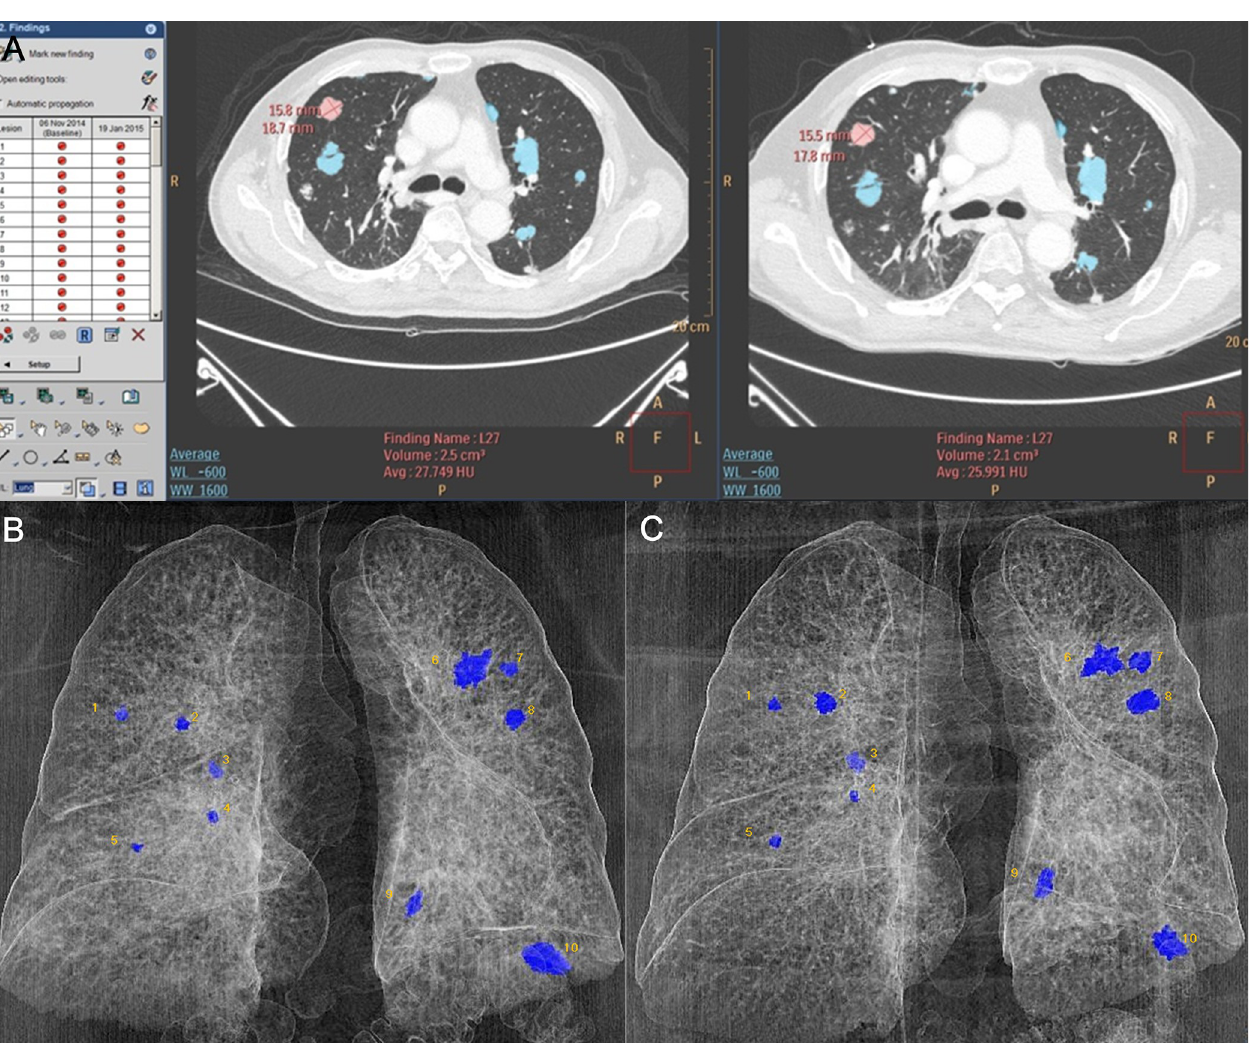
Fig 1. Lesion segmentation and tumor tracking by semi-automated 3D CT volumetry of multiple pulmonary metastatic nodules. (a) Metastatic pulmonary nodules are automatically segmented and manually edited on axial CT images of two time points using 3D visualization software. After segmentation, the 3D maximum diameter and volume of each nodule are automatically calculated. (b, c) Segmented pulmonary metastatic nodules are seen in 3D reconstructed images of baseline (b) and follow-up (c) chest CT scans.